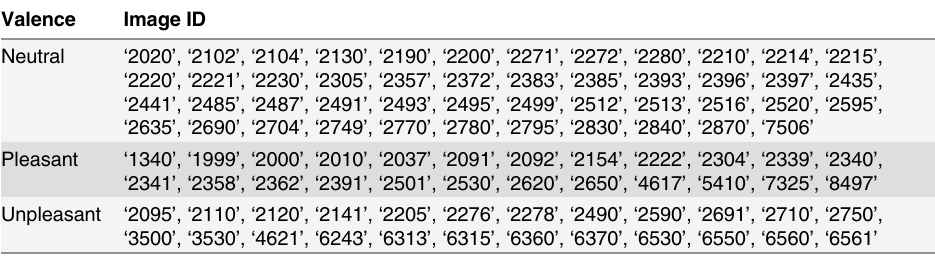
Table 2. Images used in the